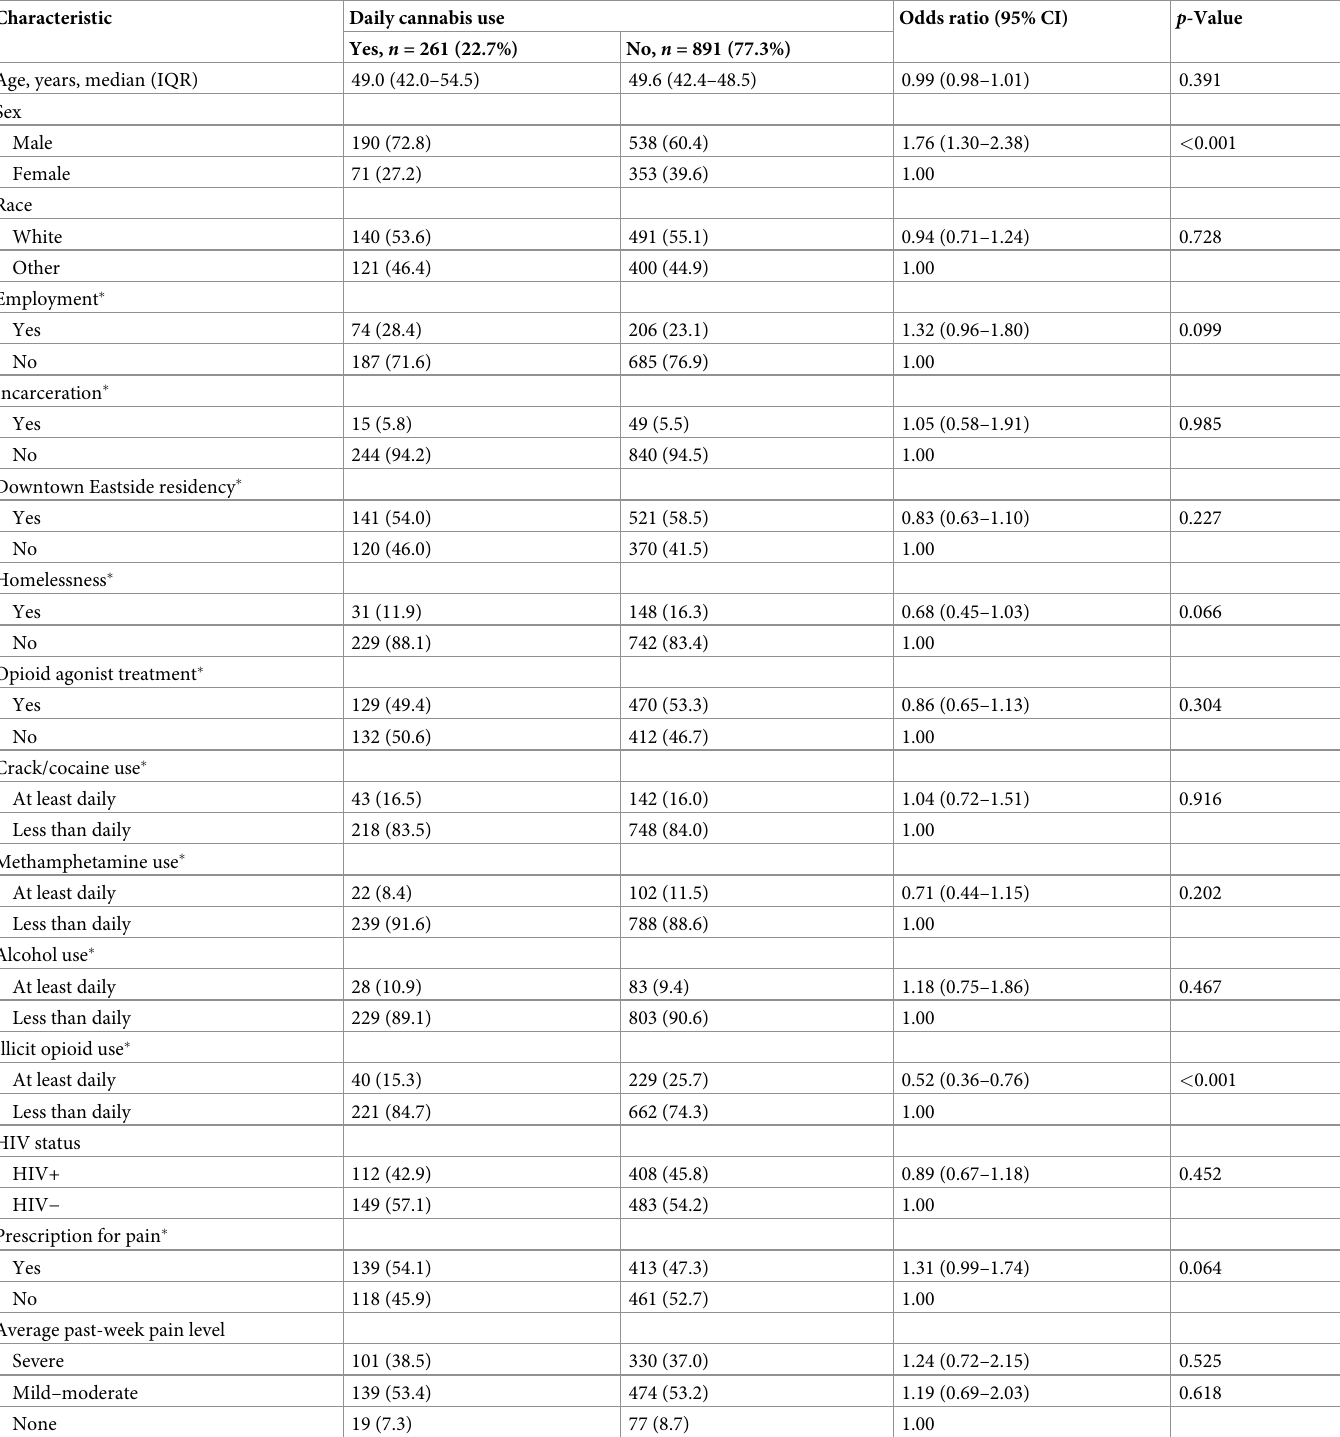
Table 1. Baseline characteristics of 1,152 people who use drugs with chronic pain, stratified by daily cannabis use.